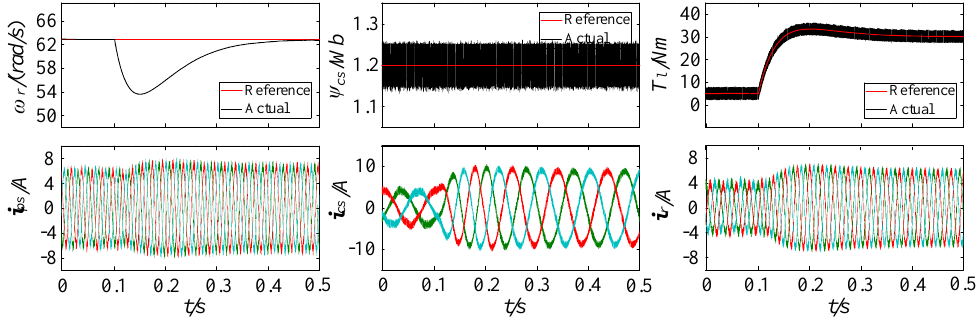
Figure 15. Load torque changes from 5 Nm to 30 Nm at 62.8 rad/s.